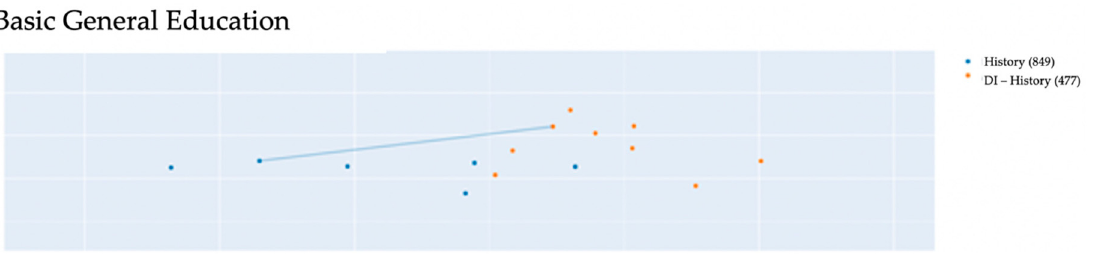
Figure 10. Semantic cluster “Rebellions”.